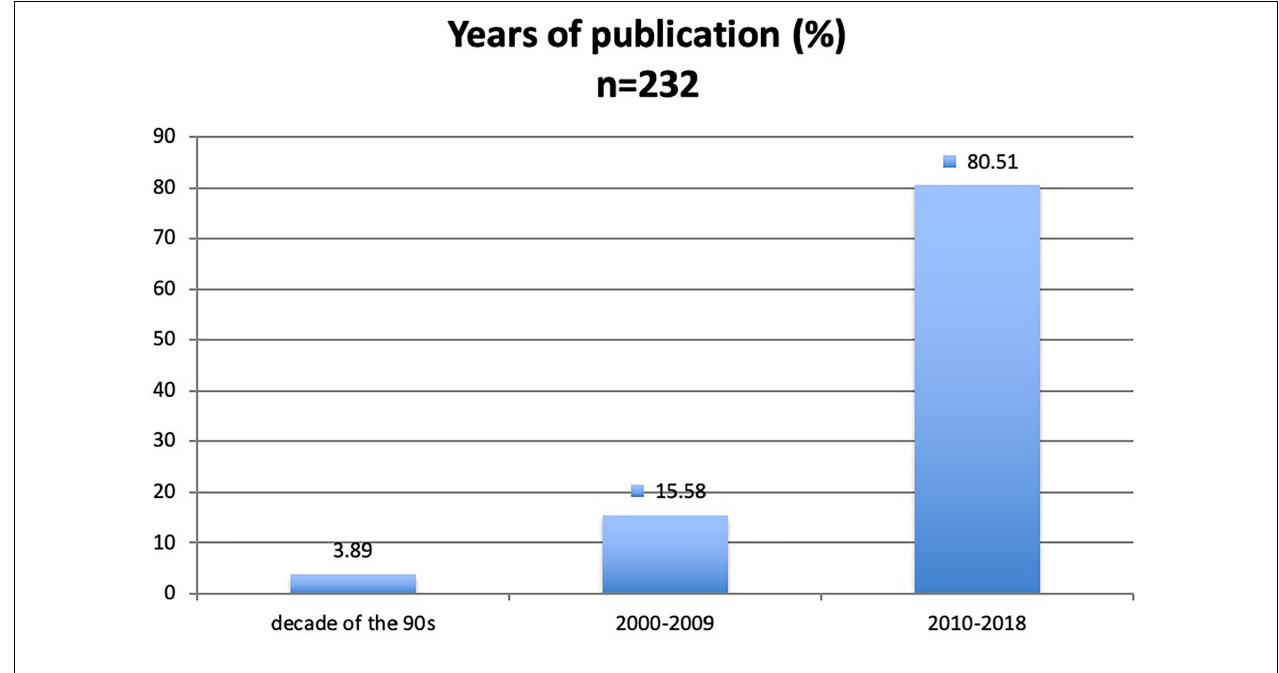
FIGURE 3 | Percentage of articles by year of publication.